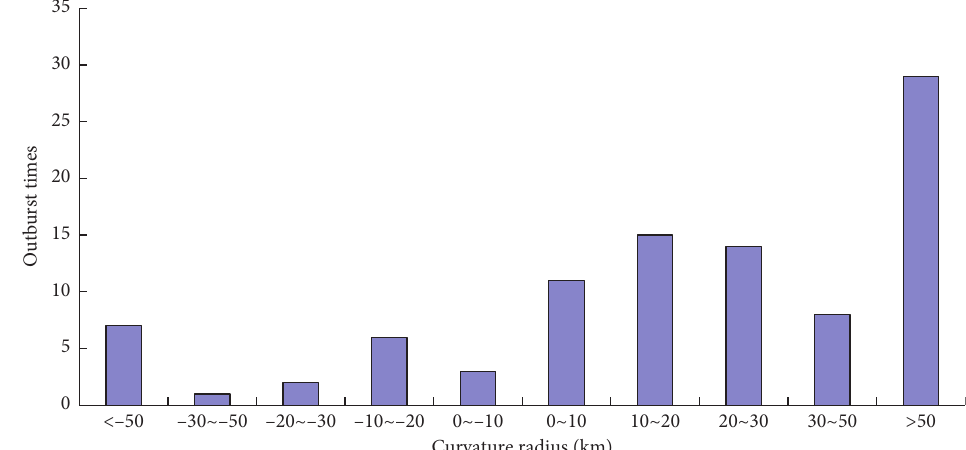
Figure 7: The relationship with curvature radius and outburst number in the Pingdingshan east